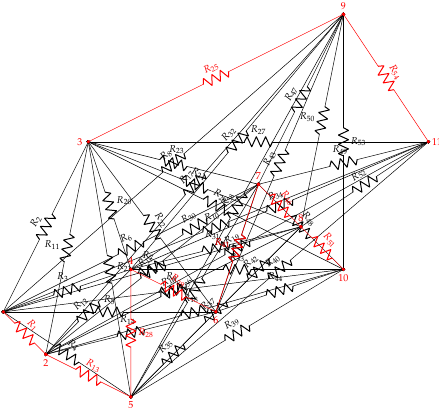
sequence of nodes in the complete path is { 1, 2, 5, 4, 6, 7, 8, 10, 11, 9, 3 } . Moreover, the total length of the path is 16.88 km.